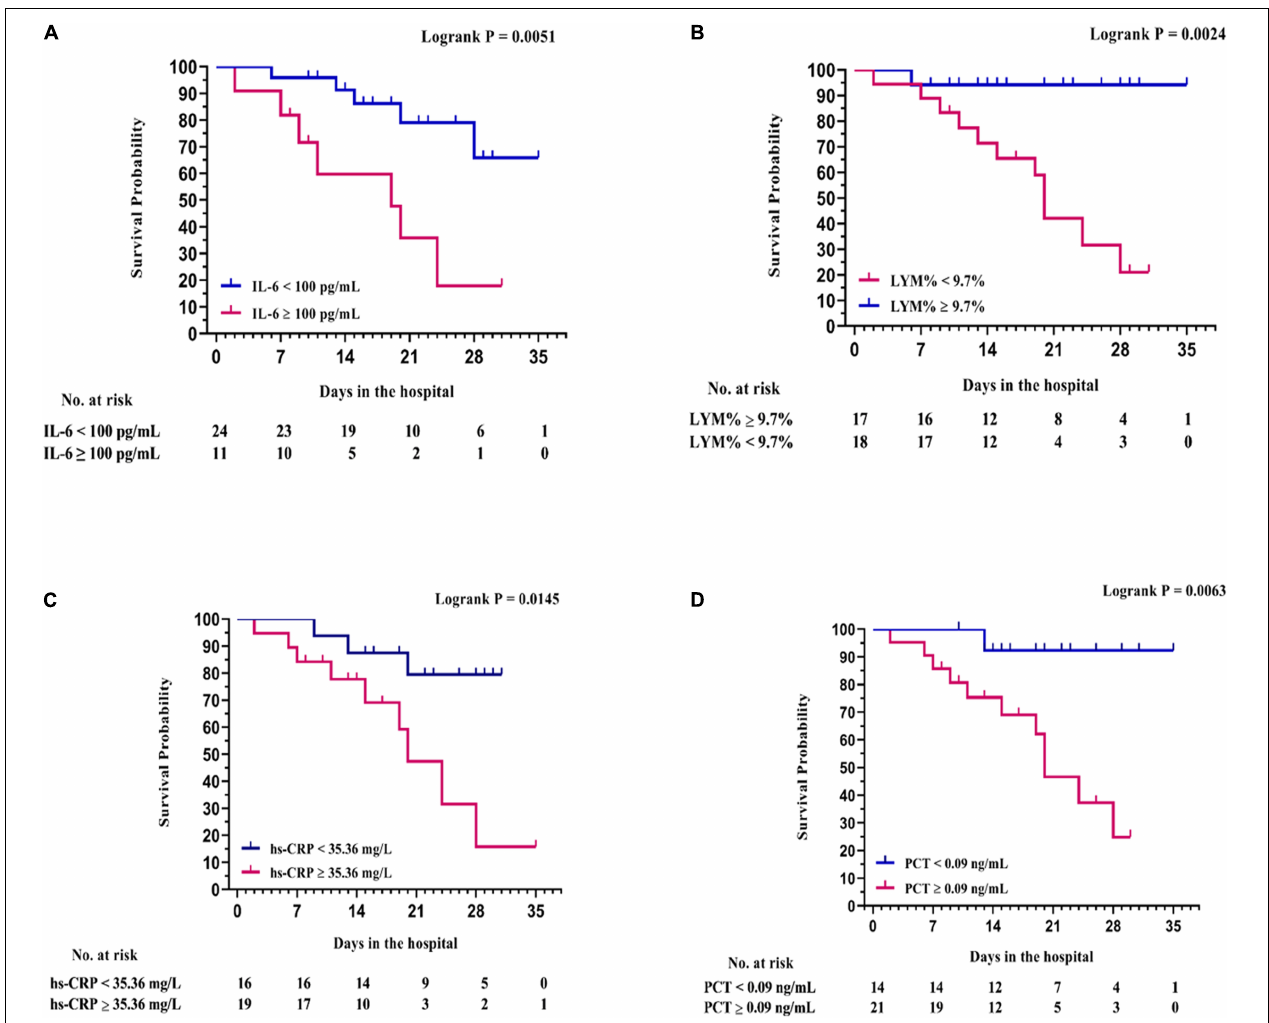
FIGURE 4 | Survival analysis with Kaplan–Meier curves between baseline laboratory examination groups. (A) IL-6, using the median value 100 pg/ml as cut-off value; (B) LYM%, using the median value of 9.7% as cut-off value; (C) hs-CRP, using the median value of 35.36 mg/L as cut-off value; (D) PCT, using the median value of 0.09 ng/ml as cut-off